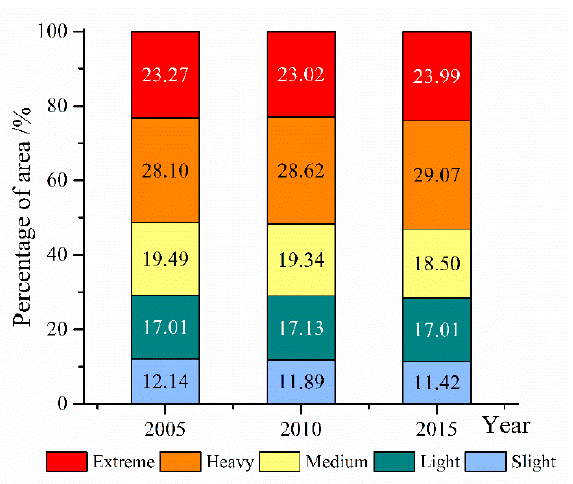
Figure 3. Area proportions of different ecosystem vulnerability levels on the Qinghai-Tibet Plateau in 2005, 2010 and 2015.